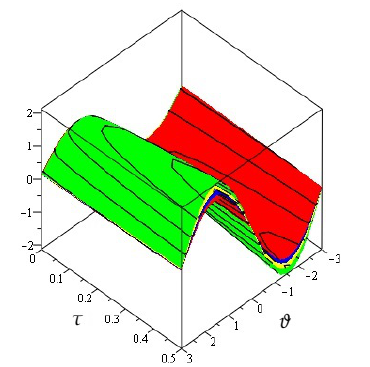
Figure 9. The different fractional-order of (cid:36) of ν ( ϑ , ζ , z , τ ) of Example 3.